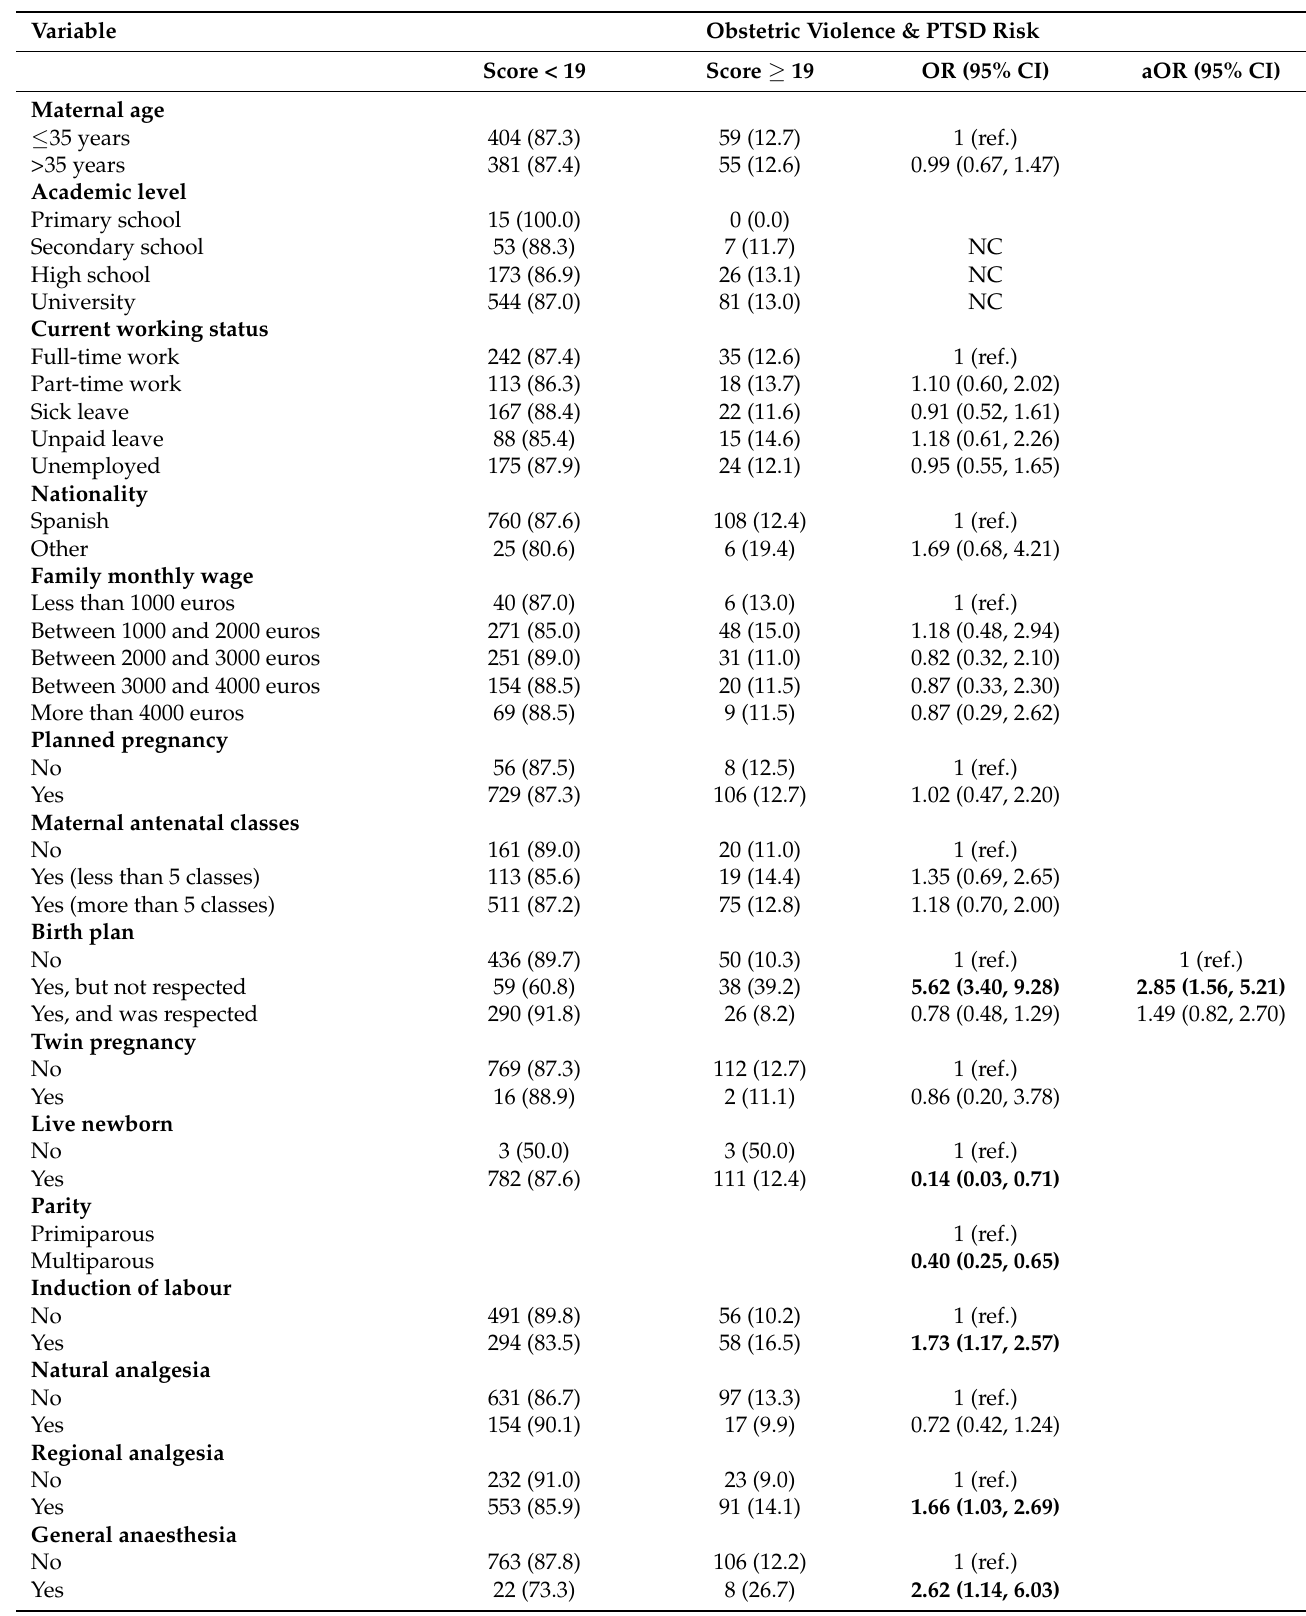
Table 2. Bivariate and multivariate analysis between sociodemographic and obstetric characteristics. Obstetric violence and